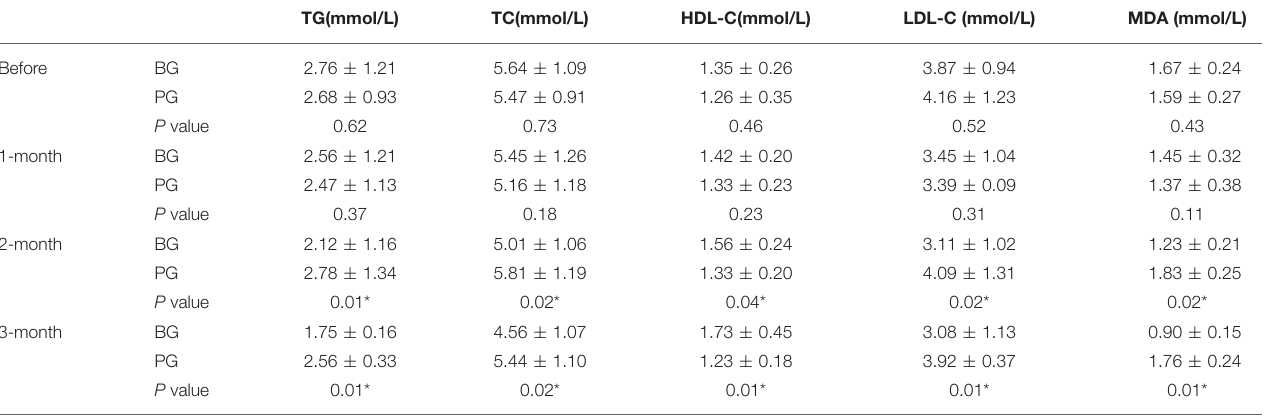
TABLE 4 | Comparison of lipid profile in CVT patients between BG and PG